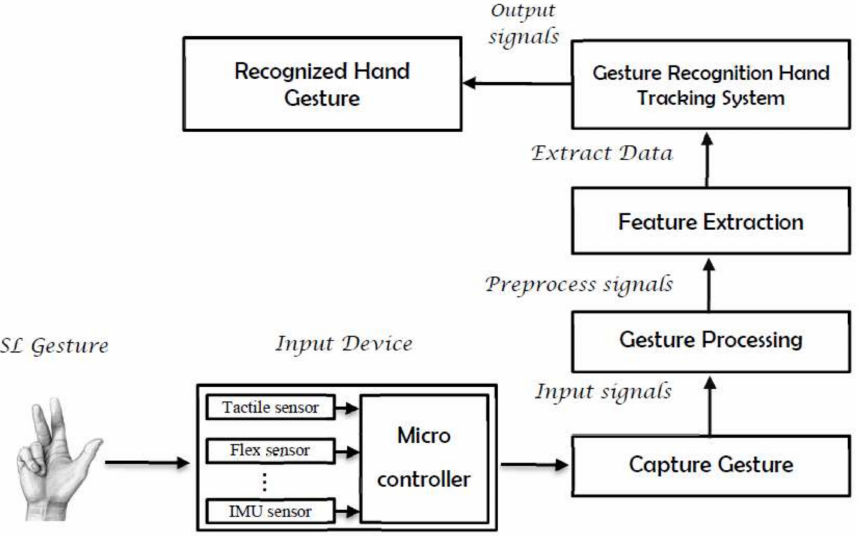
Figure 4. The main phases with regard to collecting and recognizing SL gestures data using the glove-based